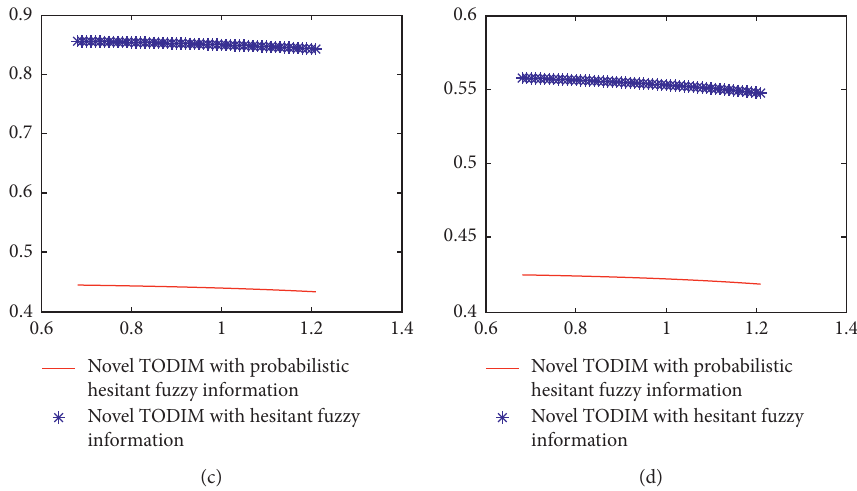
Figure 5: Sensitivity analysis of novel TODIM by changing α . 0 . 68 ≤ α ≤ 1 . 21, β � 0 . 88, δ � 0 . 69, c � 0 . 61, and λ � 2 . 25. (a) A (d) A 4